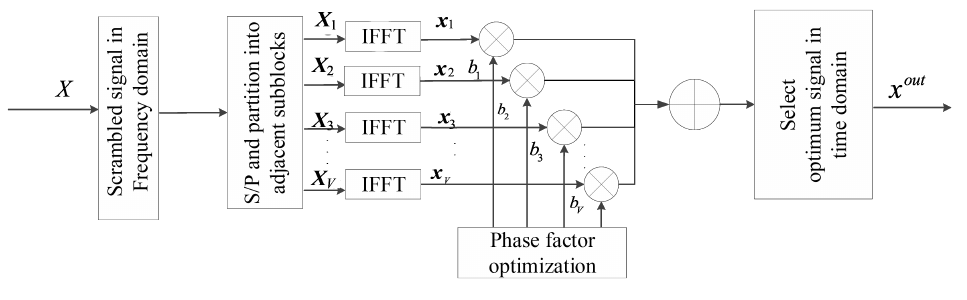
Figure 1. The structure of PTS